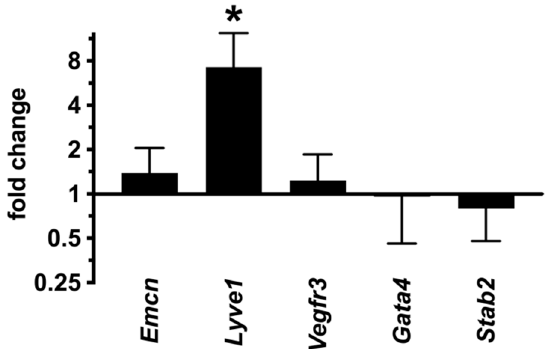
Figure 11. Lyve1 expression in the liver of dnPKA iEC mice was increased while other sinusoidal markers tested ( Emcn , Vefgr3 , Gata4 and Stab2 ) were unchanged. Mice (males and females) were injected with tamoxifen at the age of 30–35 days and dissected at the age of 61–84 days. Here, 7 control (Tg( Cdh5-cre/ERT2 ) 1Rha without floxed transgenes) and 9 dnPKA iEC mice from three different litters were analyzed. Shown are means ± SD. Data were analyzed using one-way ANOVA followed by Tukey’s multiple comparison test. *, p < 0.05.